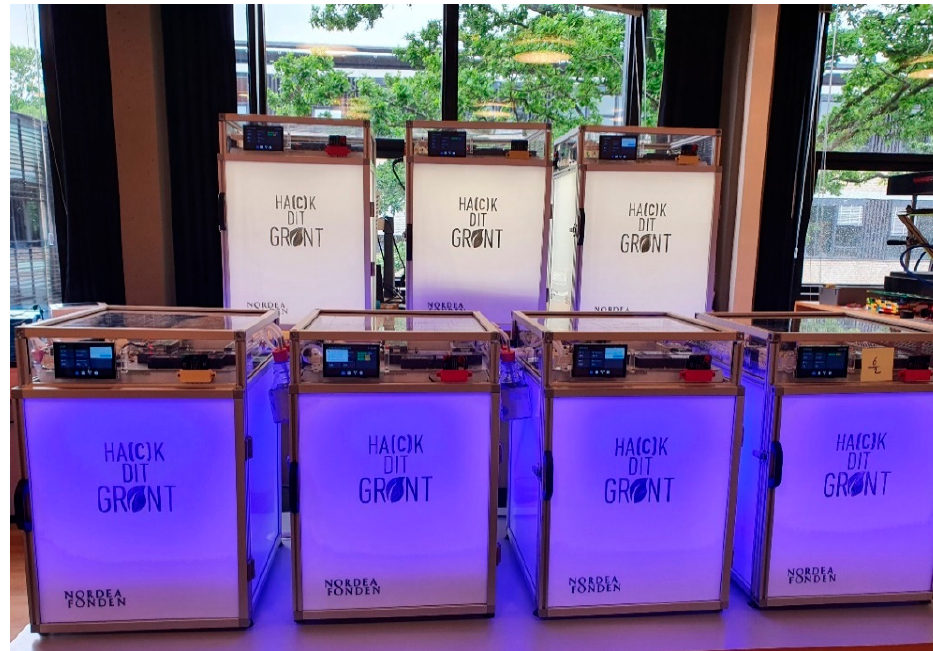
Figure 14. Seven of the nine GrowBots used in the lab for the experiment.